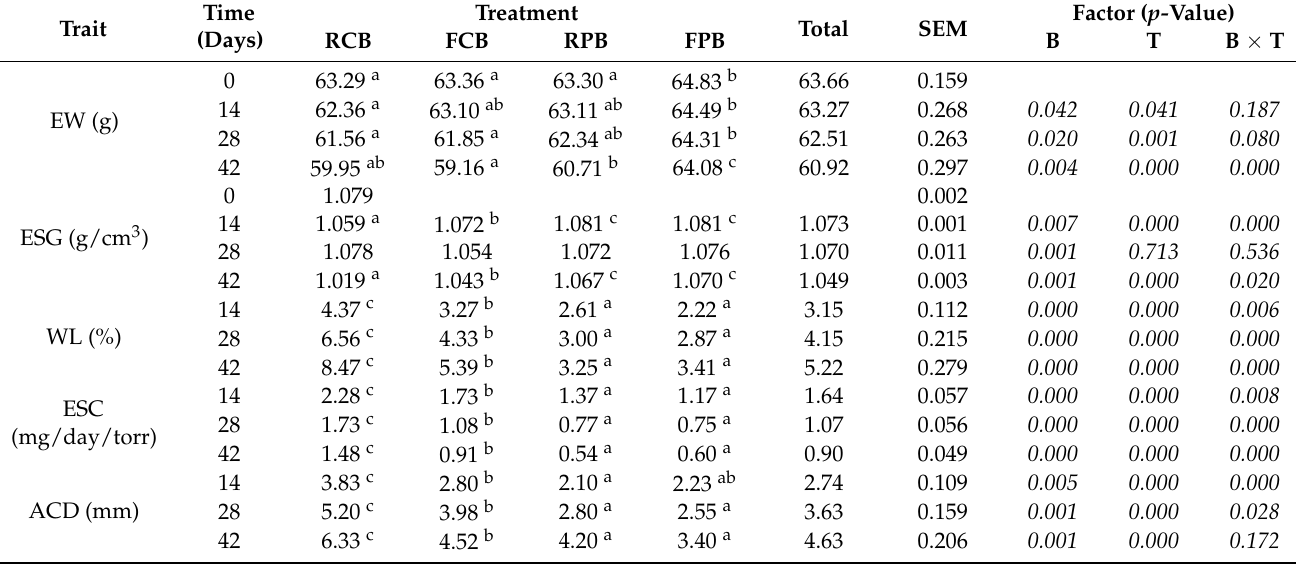
Table 2. Changes in the characteristics of the whole egg depending on packaging and storage temperature. Trait